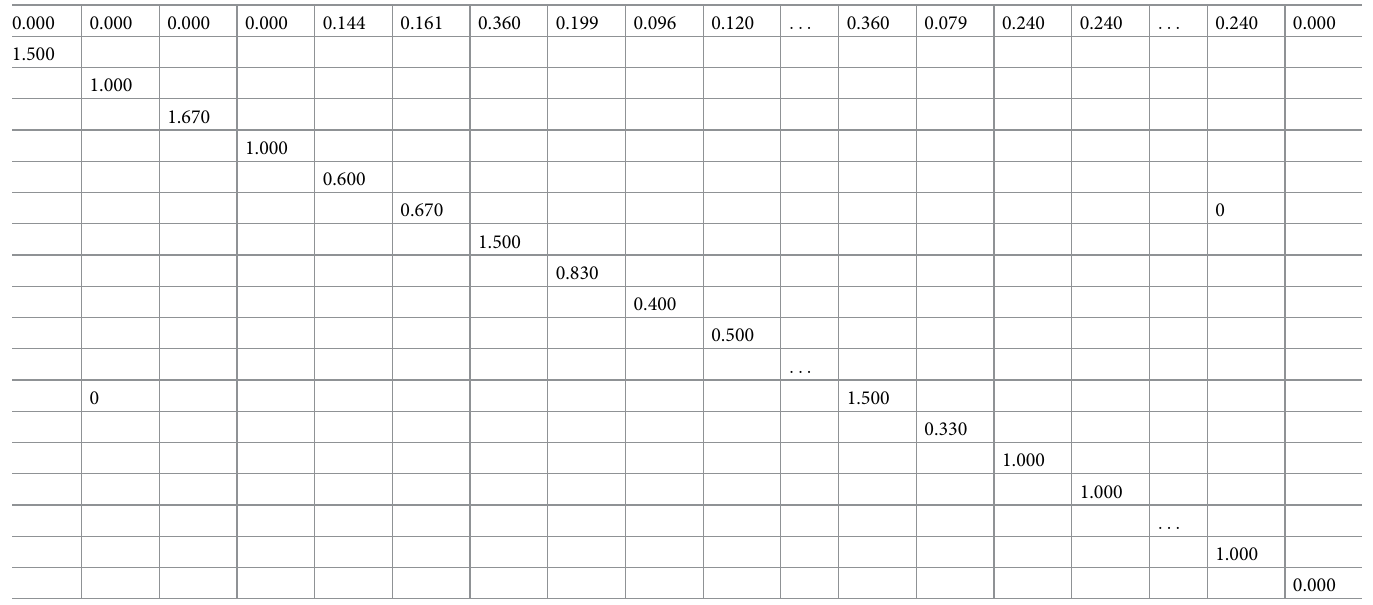
Table 12. Leslie matrix model of P . flavus BM population.